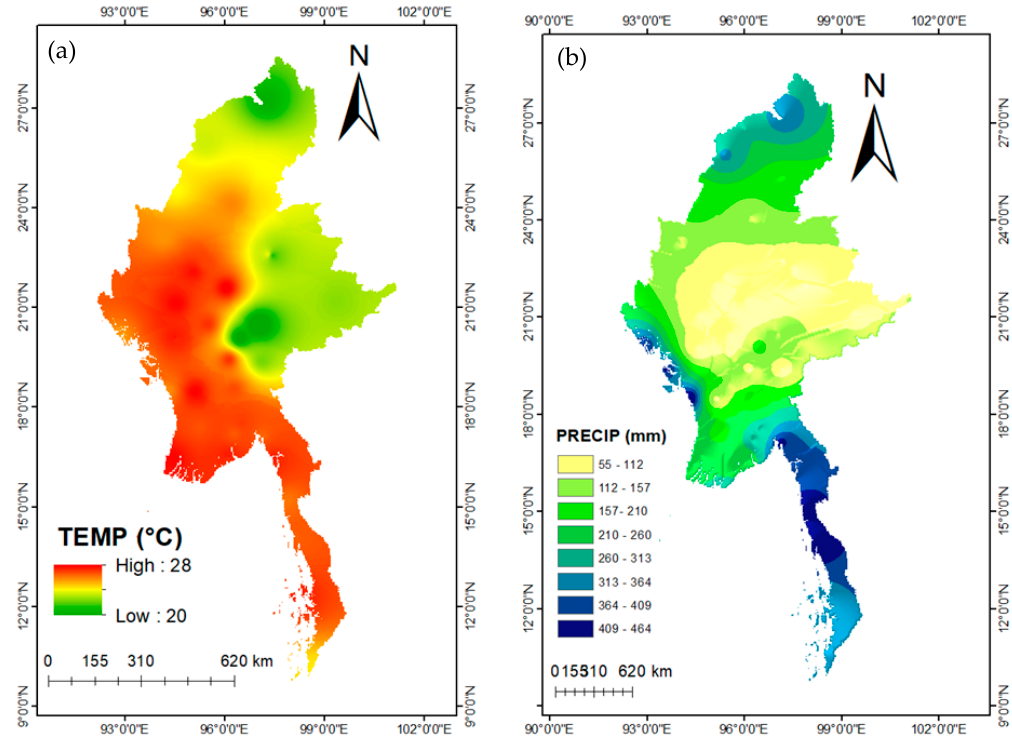
Figure 2. Spatial distribution of ( a ) temperature (°C); and ( b ) rainfall (mm) climatology over Myanmar from 1986 to 2015.